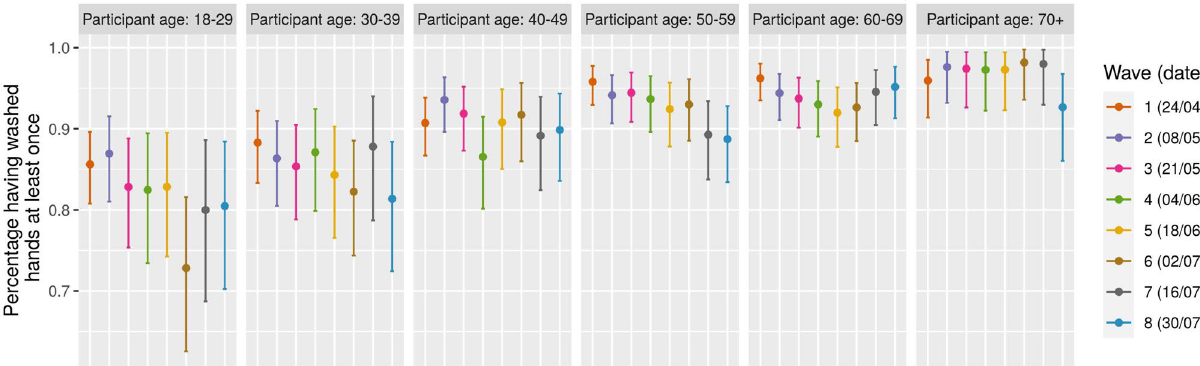
Figure 7. Percentage of participants having washed their hands. Average number of participants having washed their hands at least once in the last three hours, broken down by age. Errorbars mark the 95%